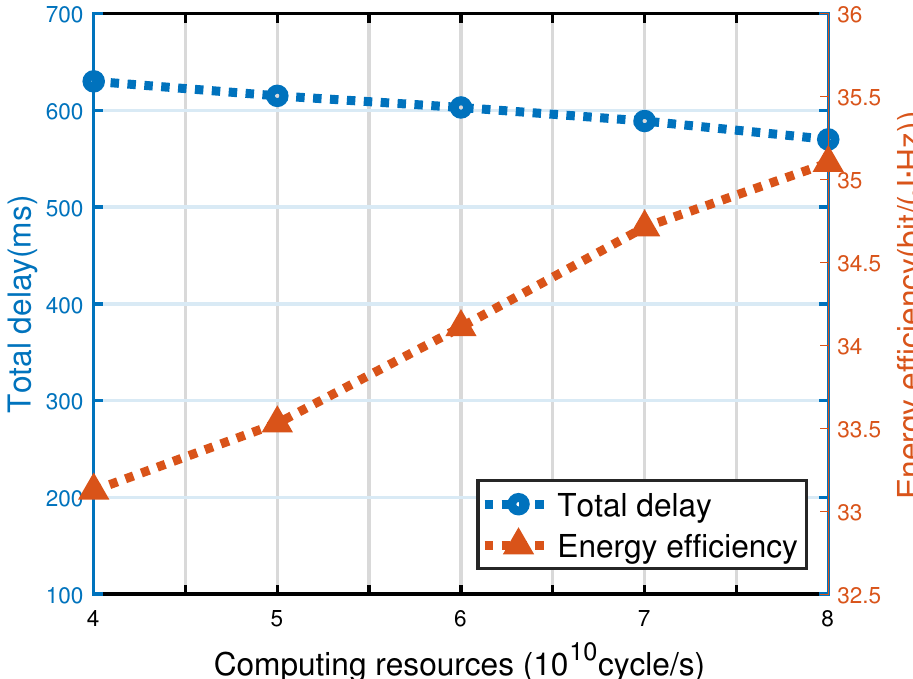
Figure 6. Total delay and energy efficiency versus computing